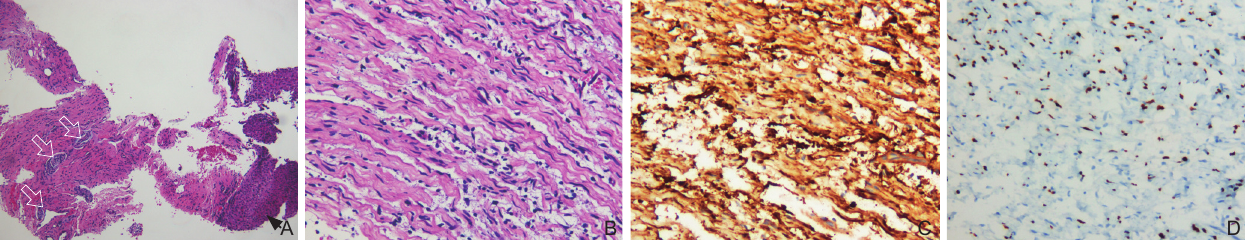
A Figure 4 Histological features and immunohistochemical results. (A) Loosely arranged spindle-shaped cells with integrated hepatic vessels distribution (open arrows) and are adjacent to normal hepatocytes (arrowheads) (H&E stain, 40× magnification); (B) At higher magnification, the sample represents spindle-shaped cells with small, wavy nuclei (H&E stain, 100× magnification). Positive expression for (C) S100 and (D) So×10.